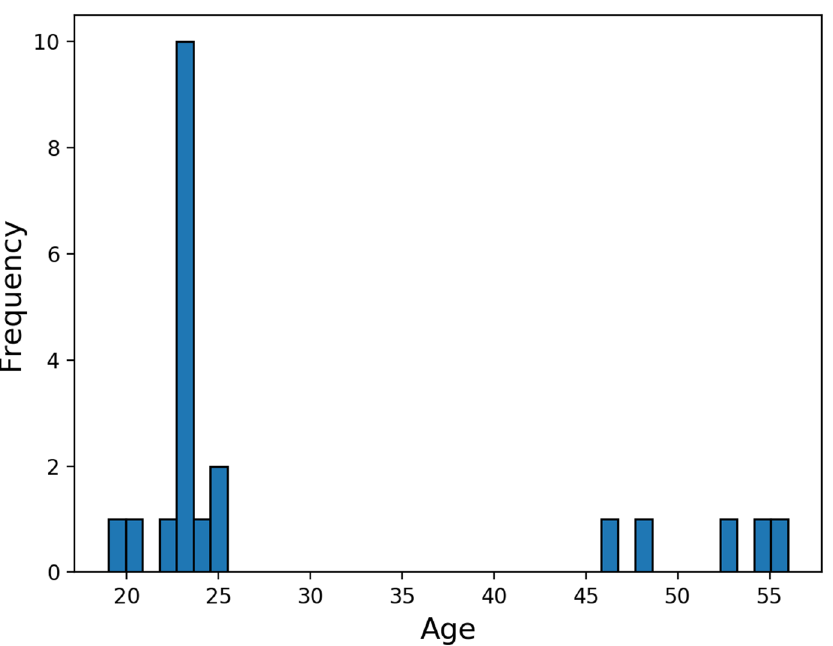
Figure 3. Subjects’ age distribution.